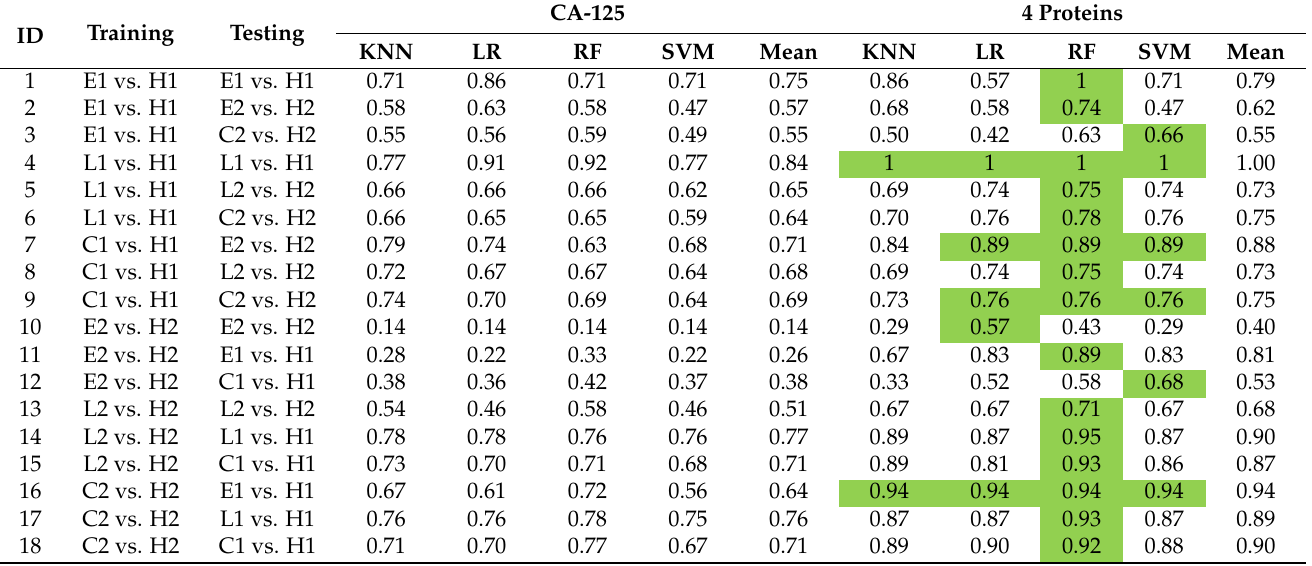
Table 3. The comparison of sensitivity between CA-125 alone and all four proteins (CA-125, MIF, OPN, and PROL) when using the four classification techniques. The sensitivity measures the ability to correctly identify condition samples and is defined as the ratio of the number of condition samples correctly classified to the total number of condition samples. We highlighted the cell(s) with best sensitivity in each experiment. Using random forest and all four proteins yield the best results on most